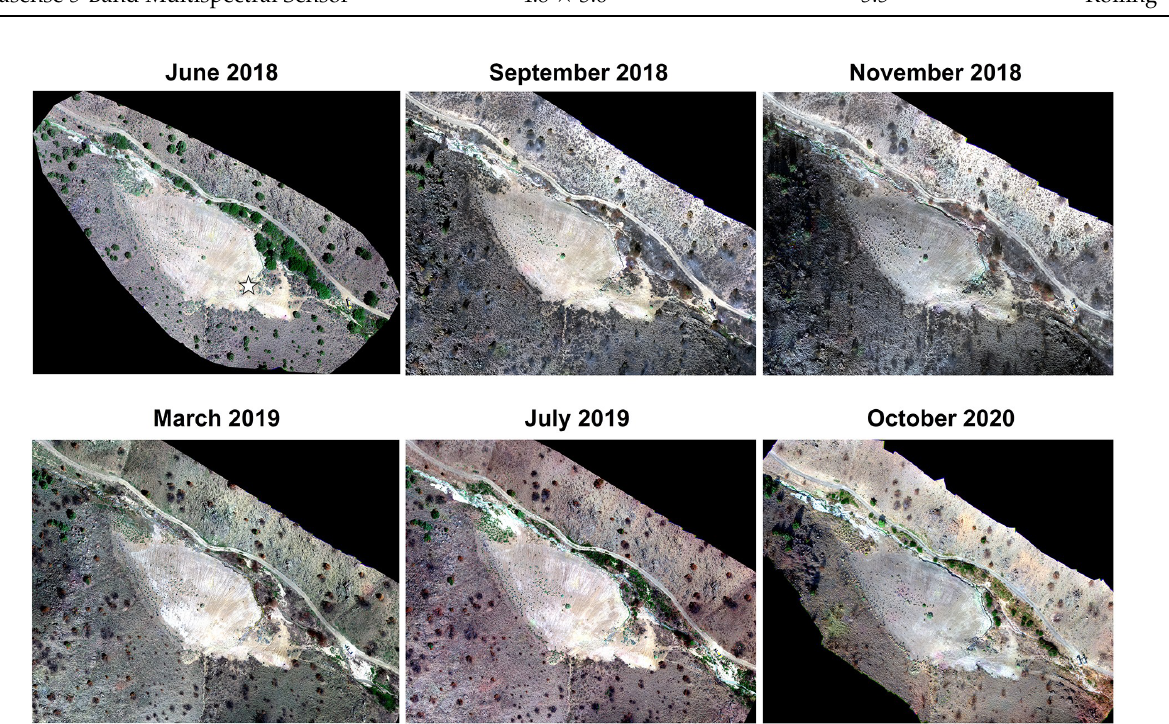
Figure 2. Approximate true color reflectance maps using MicaSense channels centered on 668, 560, and 475 nm. North is up in each image. The scene is 240 m wide and 184 m tall. The adit drain is near the southeast corner of the waste rock pile, indicated with a star on the June 18